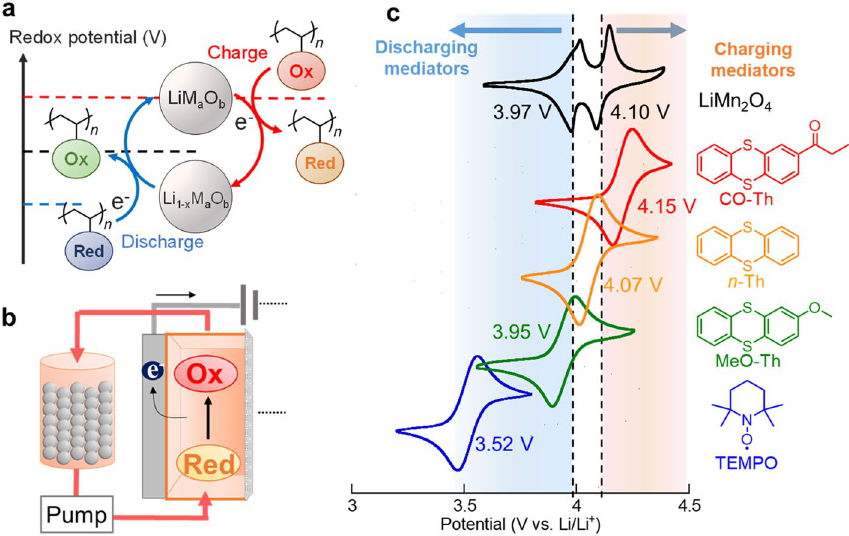
Figure 1. ( a ) Scheme of redox targeting reaction of lithium metal oxides using redox-active polymer mediators. ( b ) Illustration of a catholyte tank filled with densely packed cathode-active materials. ( c ) Cyclic voltammograms of LiMn 2 O 4 (scanned at 0.2 mV/s) and various redox mediators (5 mM, scanned at 10 mV/s) measured in 1 M Lithium bis(trifluoromethanesulfonyl)imide (LiTFSI) in ethylene carbonate/diethyl carbonate. The observed currents were normalized for